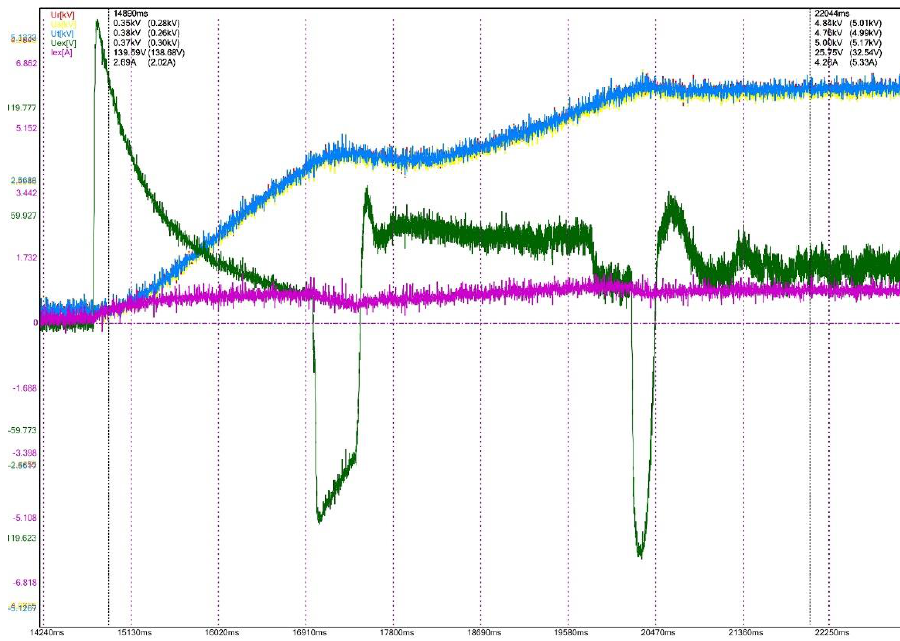
Figure 12. Power - on generator, CHE Dăești, Vâlcea.